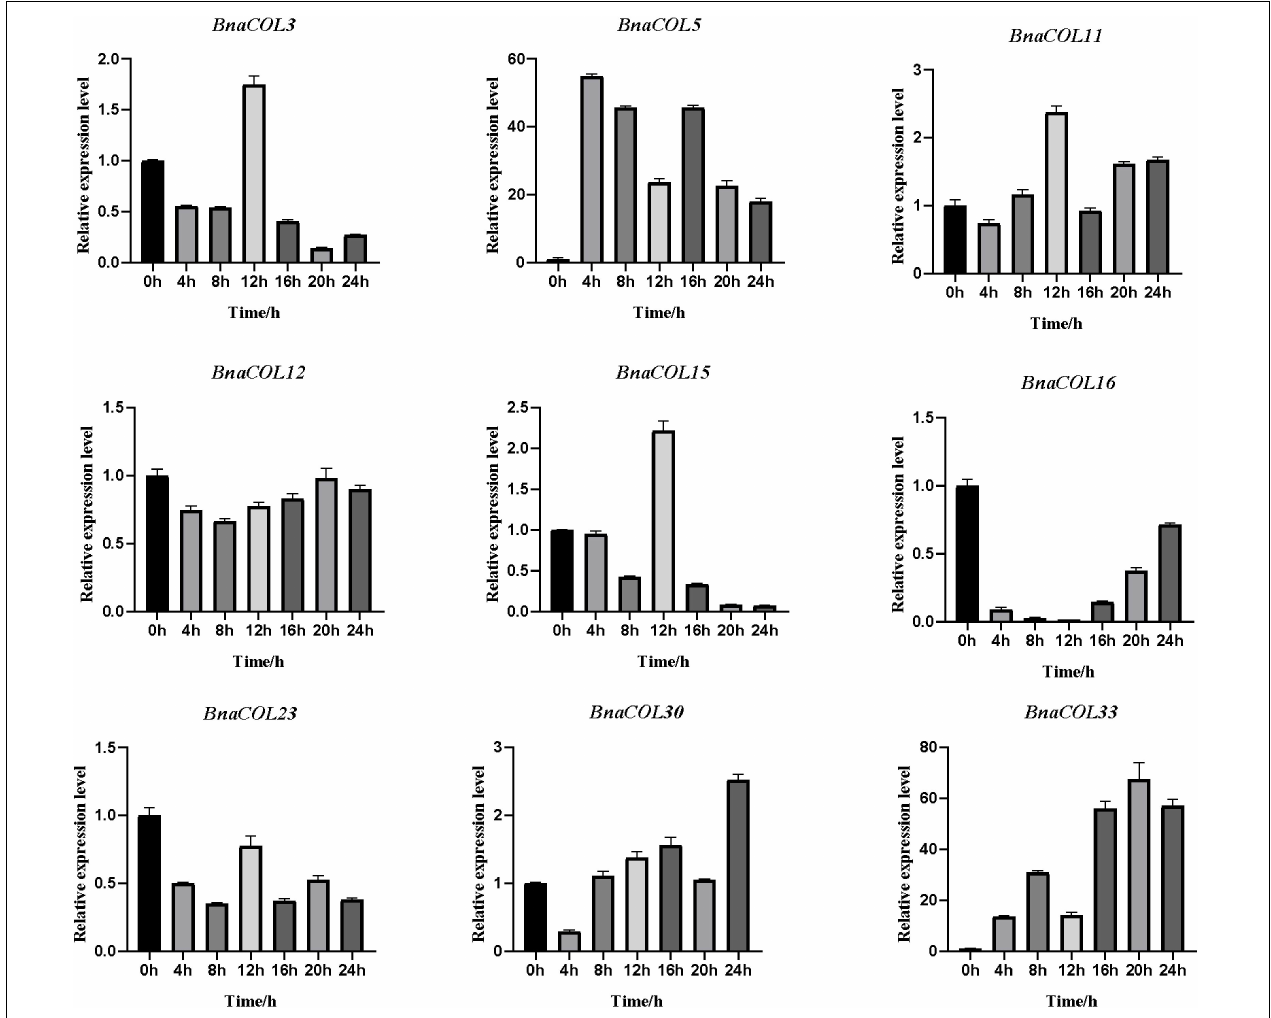
FIGURE 8 | The expression pattern of BnaCOL genes under LD conditions. Under LD (16 h dark/8 h), the third true leaf was collected every 4 h. The error column represents the standard deviation of the three biological